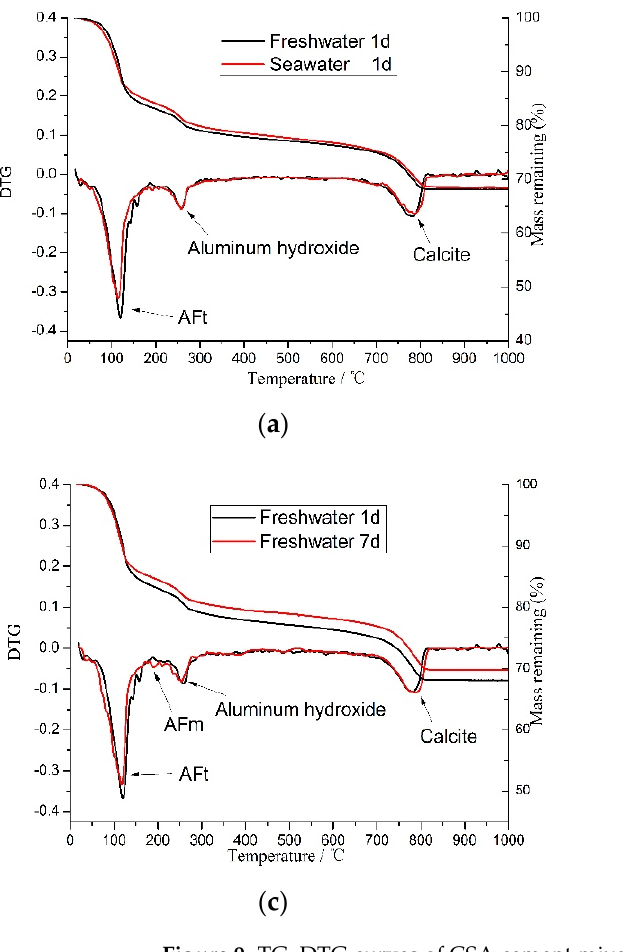
Figure 9. TG–DTG curves of CSA cement mixed with different types of water at 1 d and 7 d.